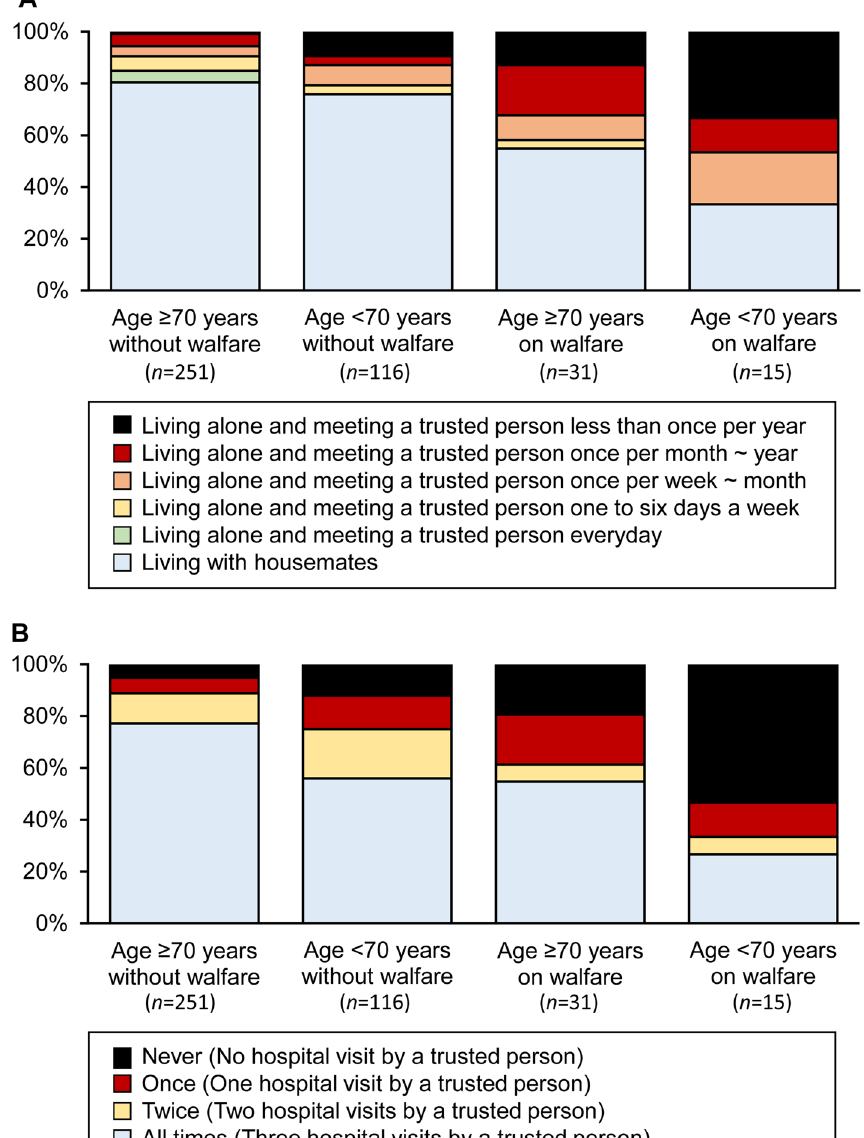
Figure 2. Social isolation according to age and receipt of welfare in the study population ( n = 413). ( A ) Shows the proportion of patients living with housemates and those living alone (segmentized according to the frequency of meeting a trusted family member or friend). ( B ) Shows the frequency of the hospital visitation of patients living alone by a trusted family member or friends on three key occasions: (1) the patient’s first visit to the vascular center; (2) the preoperative explanation regarding the planned operation; and (3) the day of the